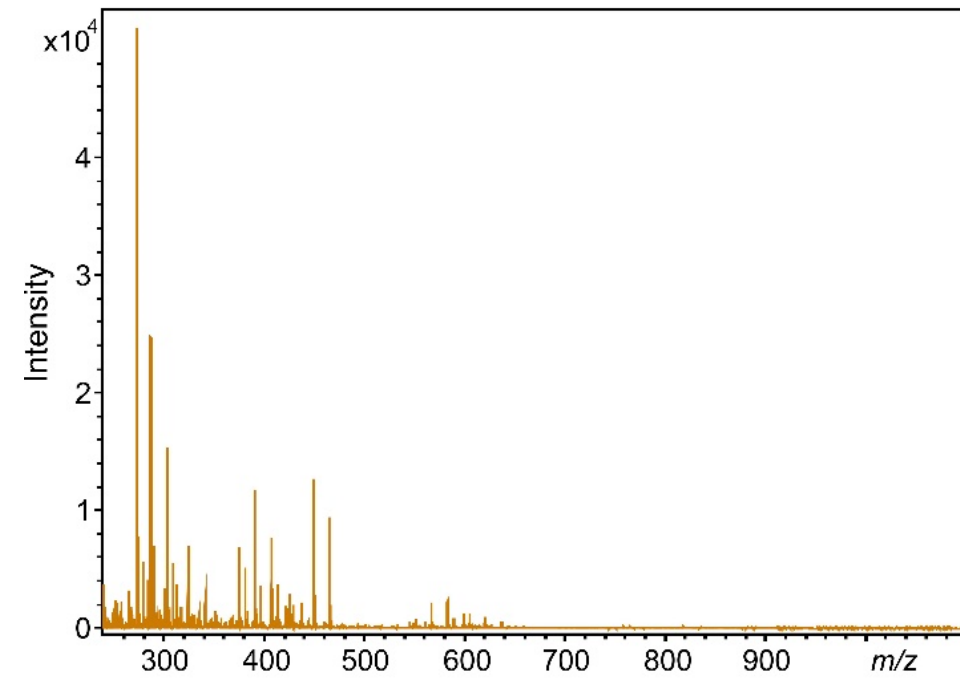
Figure 1. MALDI-TOF-MS spectrum of PEG 400 with DHB matrix and Na + ionization agent.